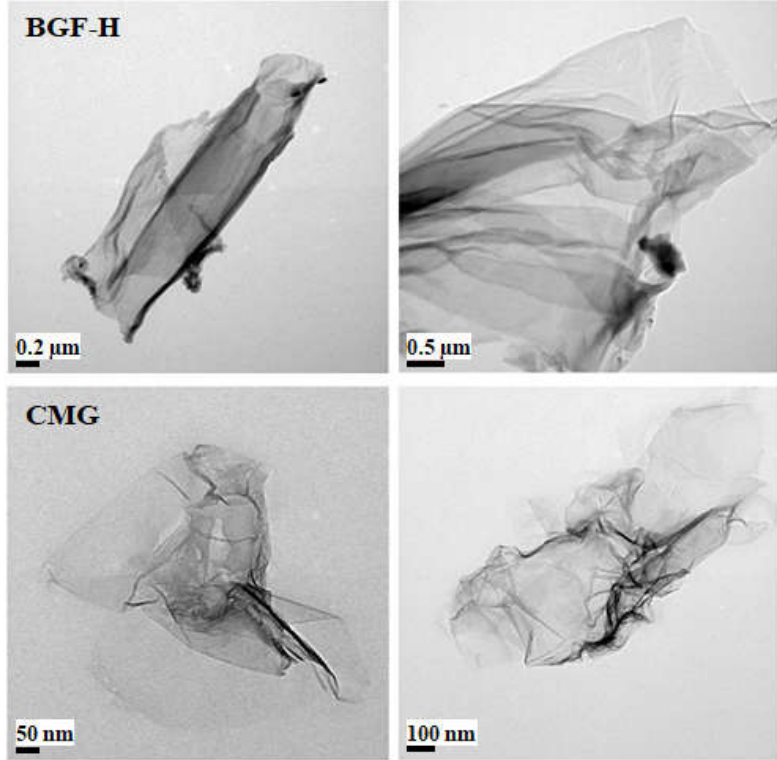
Figure 3. TEM observation of non-oxidized graphene (BGF-H) and CMG.